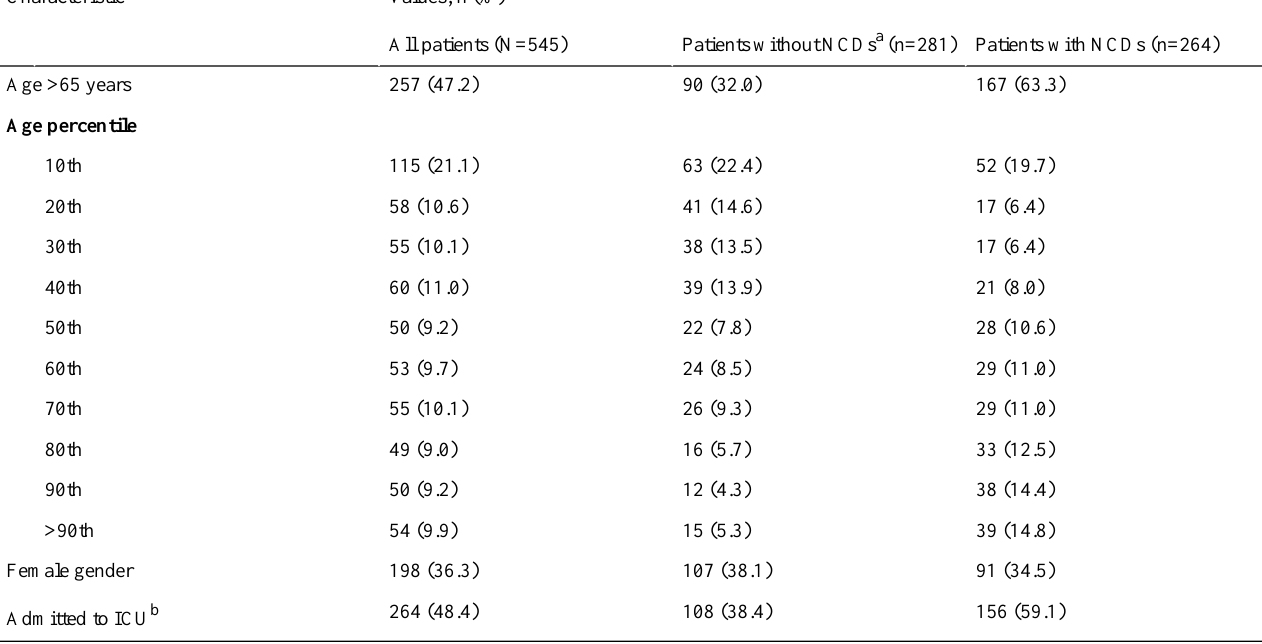
Table 1. Demographic information for the patients with COVID-19 in each patient group. Values, n